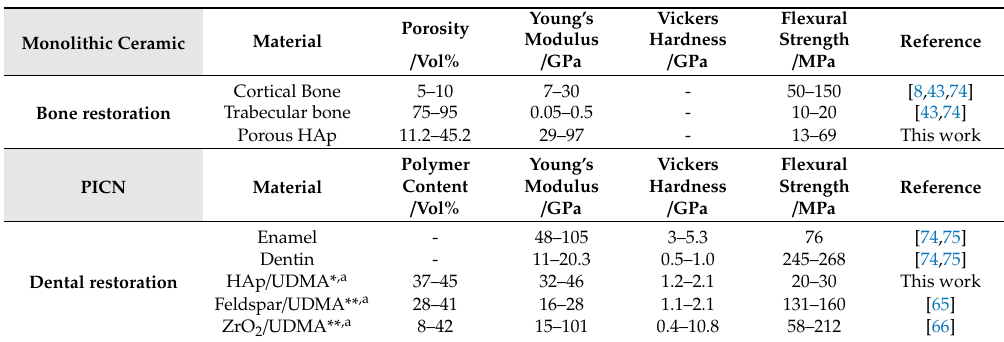
Table 3. Mechanical properties of the monolithic porous HAp ceramics and interpenetrating HAp / UDMA composites in comparison to human bone, teeth and UDMA-based polymer infiltrated ceramic networks